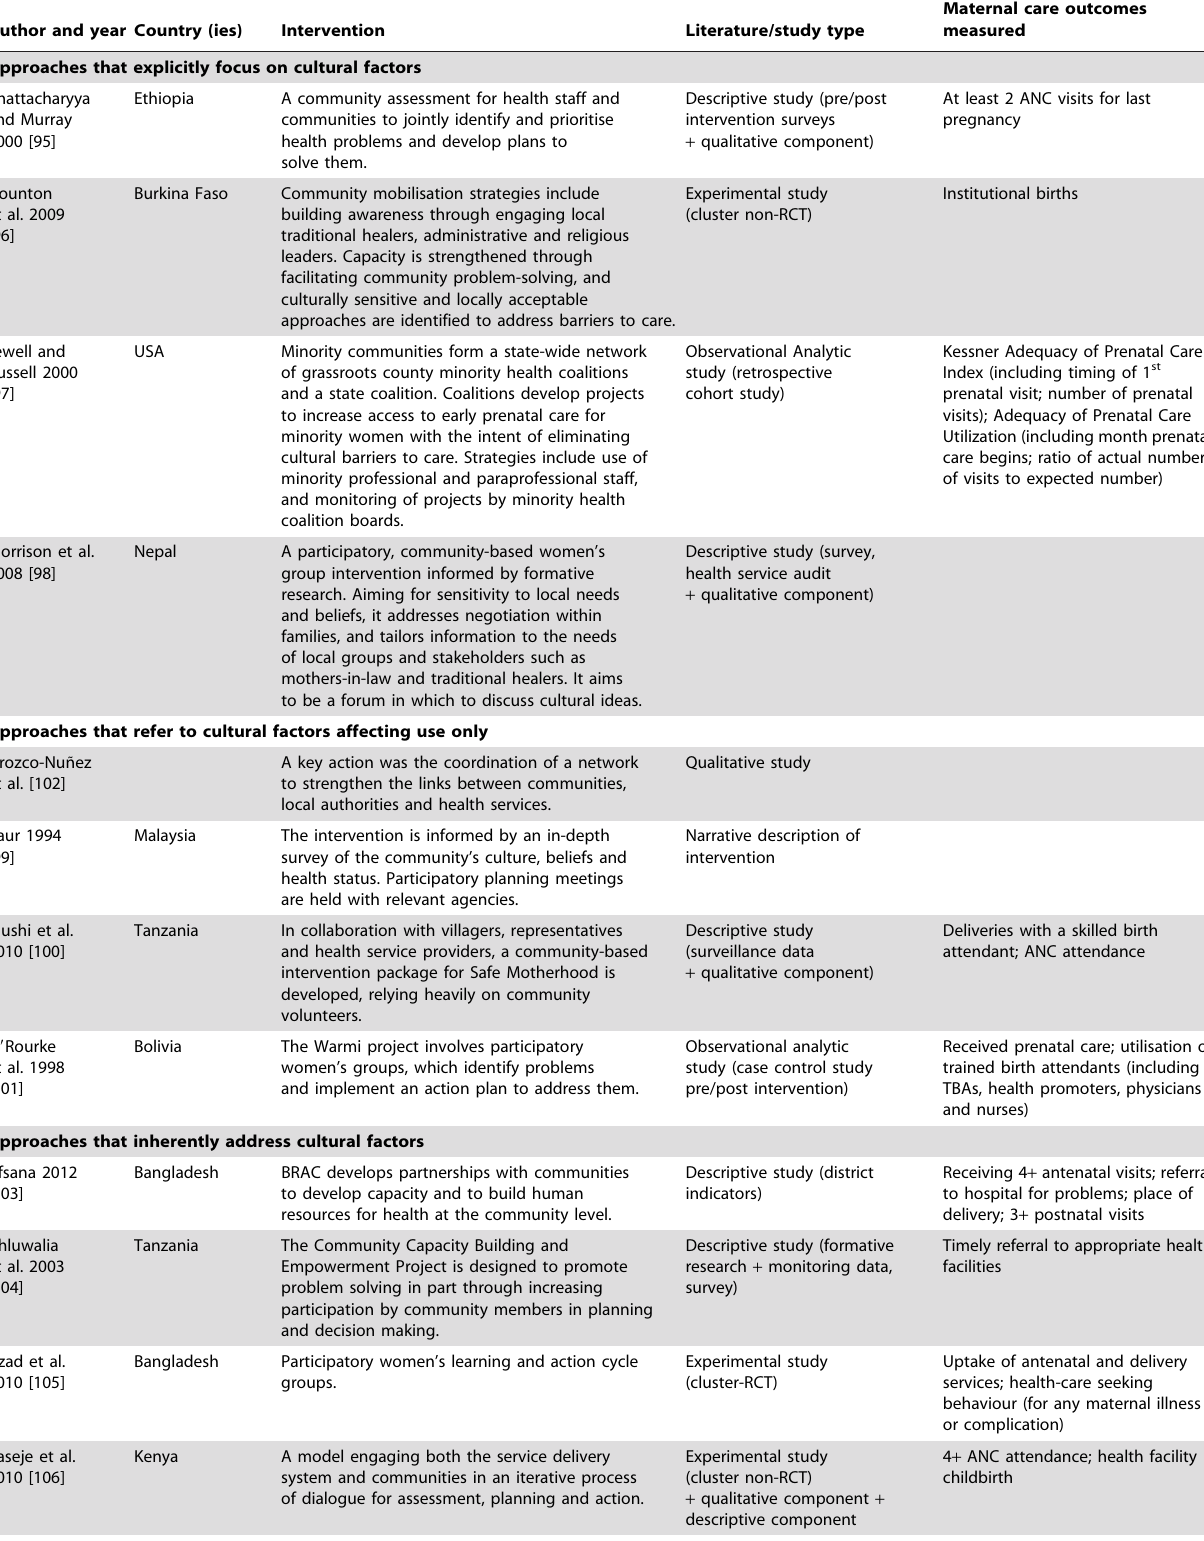
Table 6. Included items: Participatory